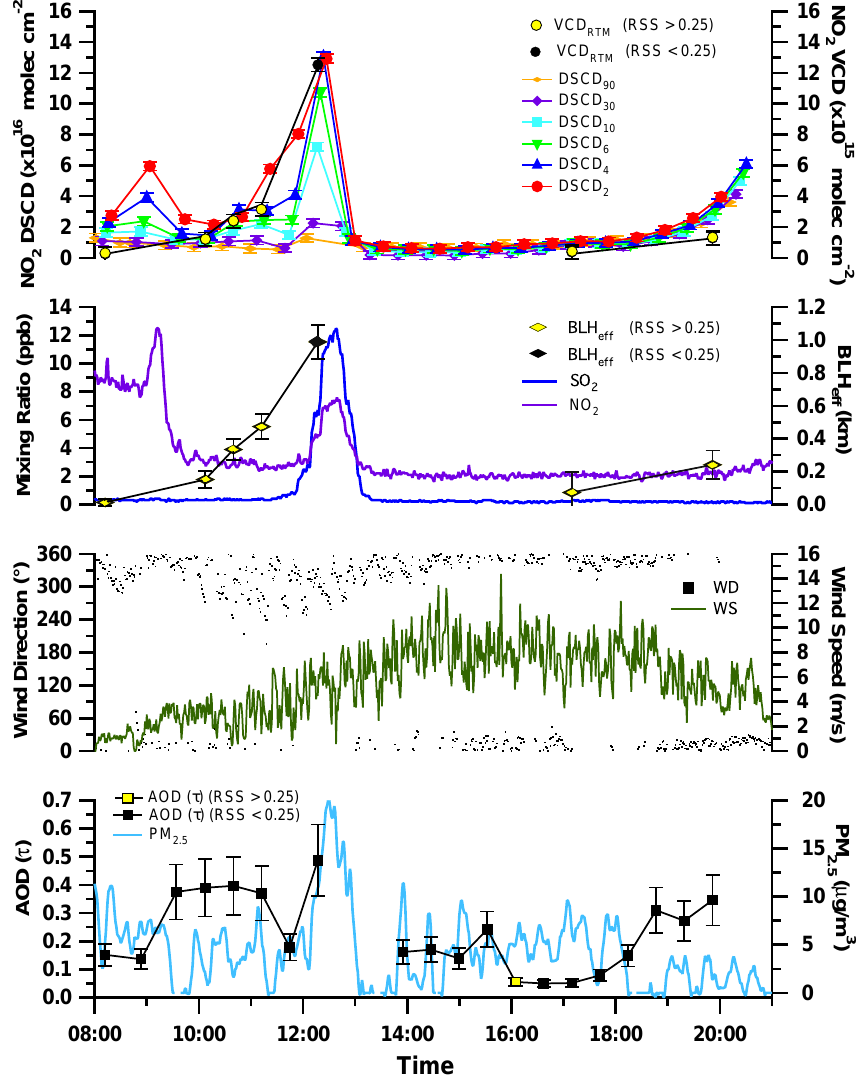
Fig. 13. Measurements at Ridgetown on 30 June 2007. NO 2 MAX-DOAS DSCDs with NO 2 VCD RTM values are followed by ground level measurements of SO 2 and NO 2 , BLH eff , wind direction, wind speed, PM 2 . 5 , and AOD ( τ RTM